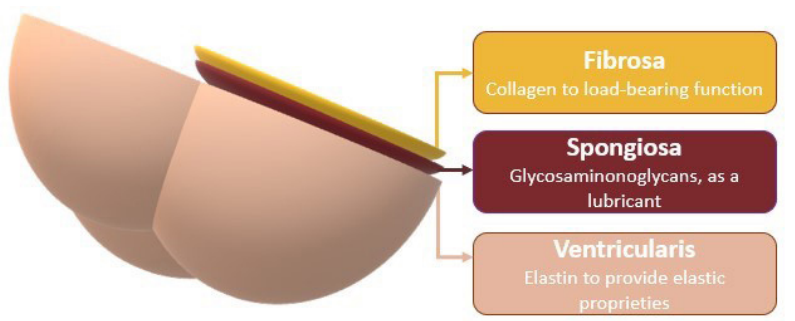
Fig. 1 - Schematic image of the three cardiac valve